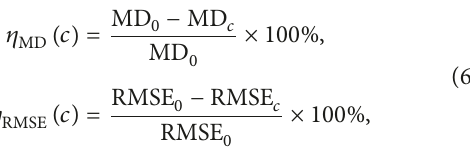
Figure 4: Dependence of mean standard deviation of CBH on range from the point of observation. The dashed fitted curve is a piecewise continuous function.